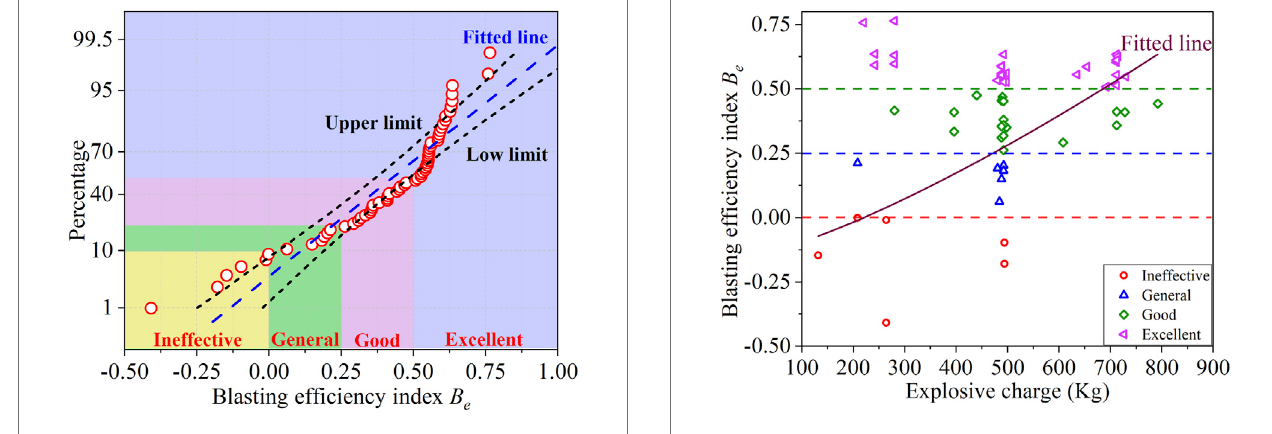
FIGURE 10 | Normal probability distribution of the blasting ef fi ciency index B e .